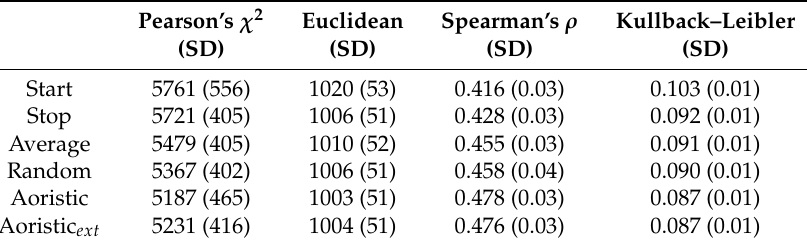
Table 9. Mean and standard deviation for the four evaluation measures and the six temporal analysis methods that were evaluated with the day of year data over each of the five